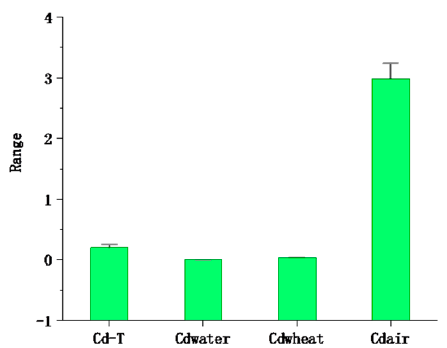
Figure 6. The mean ± standard error of cadmium in multiple media at the 95% confidence interval (the unit of Cd-T, Cdwheat, and Cdair is mg / kg, and the unit of Cdwater is mg / L).